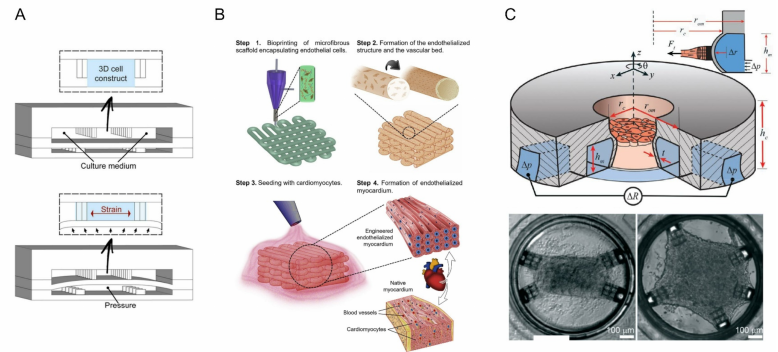
Figure 4. Heart-on-a-chip system. ( A ) Neonatal rat and human induced pluripotent stem cell-derived cardiomyocytes (hiPSC-CM) were suspended in a fibrin gel matrix and filled in the central channel. The PDMS membrane is deformed by pressurizing the bottom compartment. Due to the presence of openings between the columns, compression translates into the significant uniaxial strains applied to the 3D cell structure. Reprinted with permission from Ref. [43]. Copyright 2016 Royal Society of Chemistry. ( B ) Schematic diagram of 3D bioprinting manufacturing endothelialized myocardium. Reprinted with permission from Ref. [44]. Copyright 2016 Elsevier. ( C ) The seeding well in the middle was surrounded by a ring of micro-channels for driving and detection. The illustration shows a cross- section of the protruding wall. The “cage” on the wall of the device limited collagen remodeling and acted as an attachment point for cells. By customizing the position of the cage, different tissue shapes could be defined (rectangle and pentagon were shown in the picture) Reprinted with permission from Ref. [46]. Copyright 2021 Royal Society of